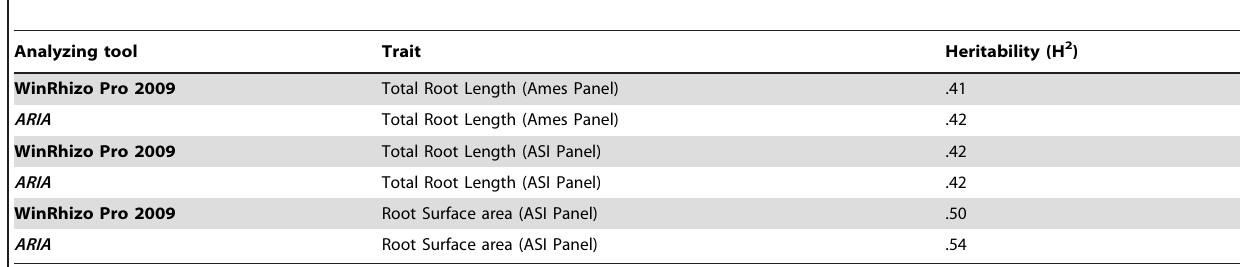
Table 2. Comparison of repeatability estimates for both WhinRhizo Pro 9.0 and ARIA.